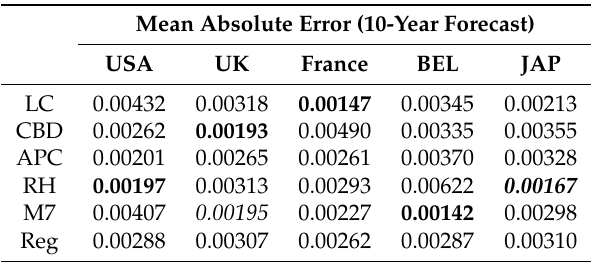
Table 3. Similar table as Table 2 but based on historical data from 1970 to 2007. Mean Absolute Error (10-Year Forecast) USA UK France BEL